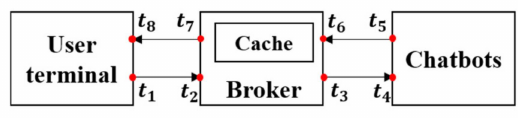
Figure 9. Response time of the system